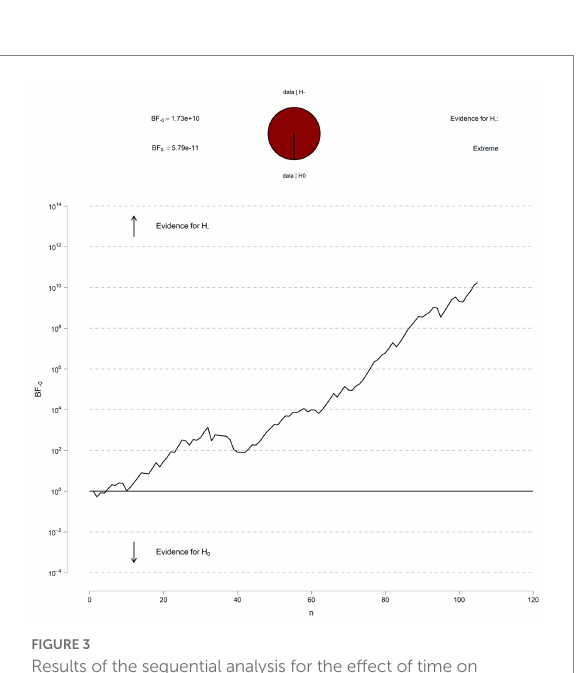
FIGURE 3 Results of the sequential analysis for the effect of time on knowledge.